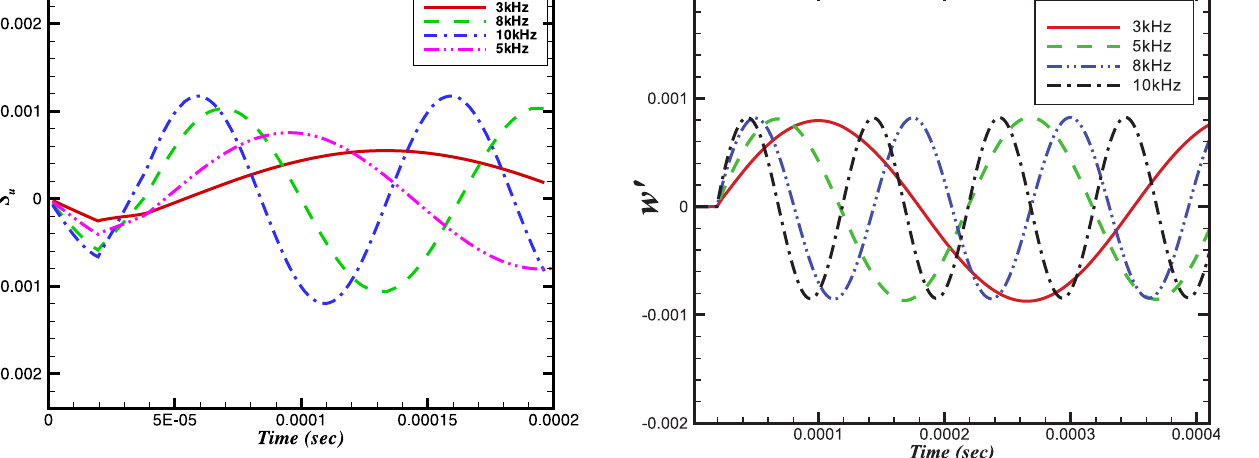
Figure 16. Relative change in the reaction rate of CH 4 at different frequencies and a constant amplitude of 100 Pa.